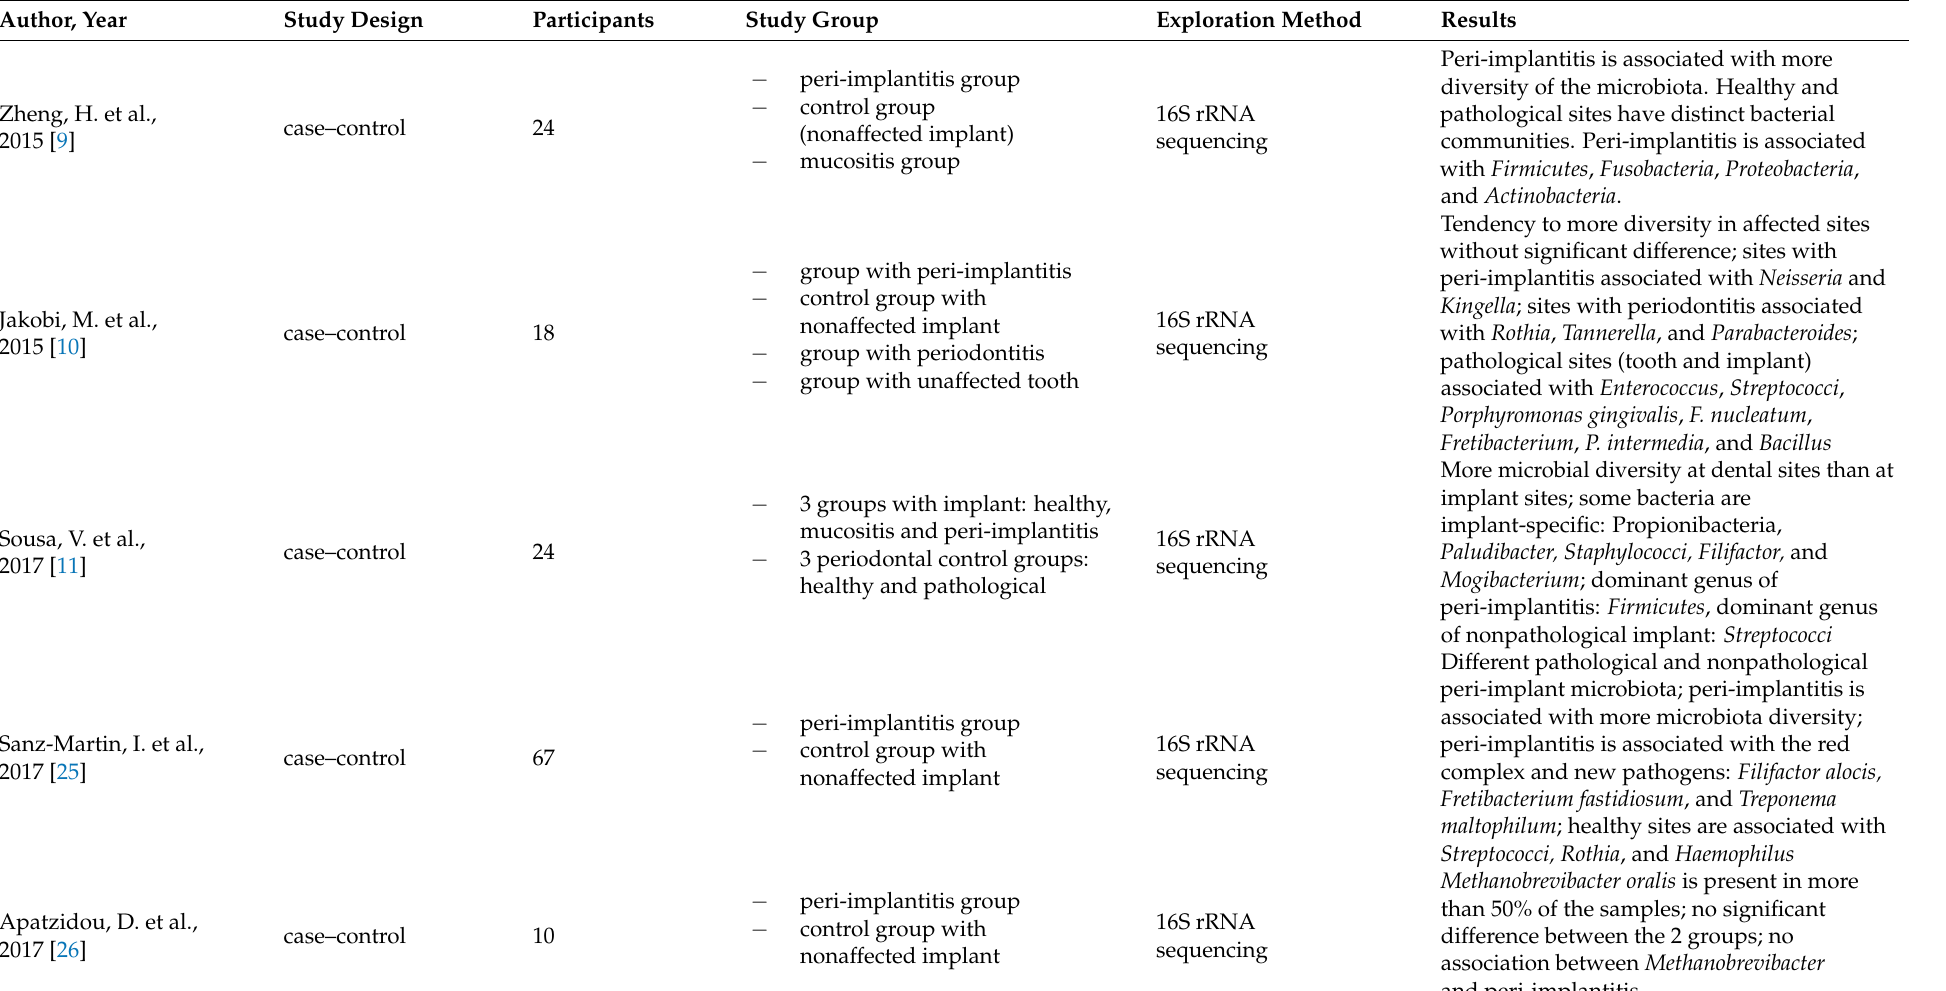
Table 1. Characteristics of the included